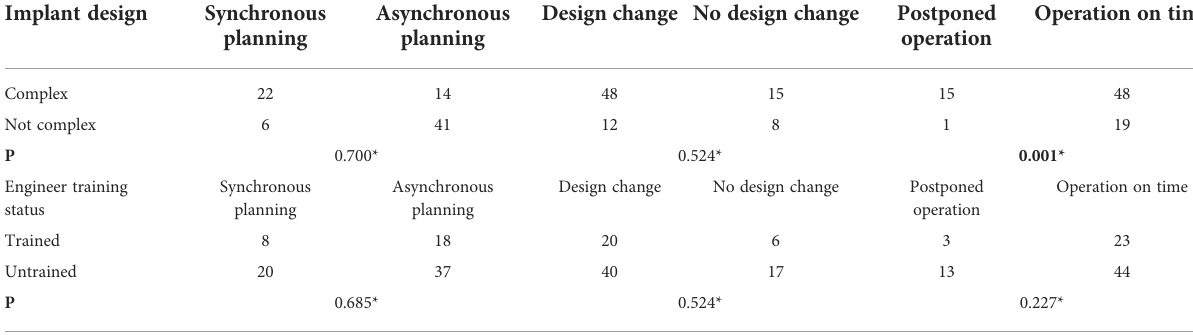
TABLE 1 Outcomes depending on implant complexity and engineer training status. Implant